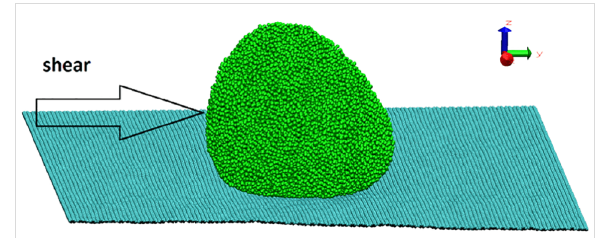
Figure 1: Perspective snapshot of the formed nanoparticle containing 20000 Al